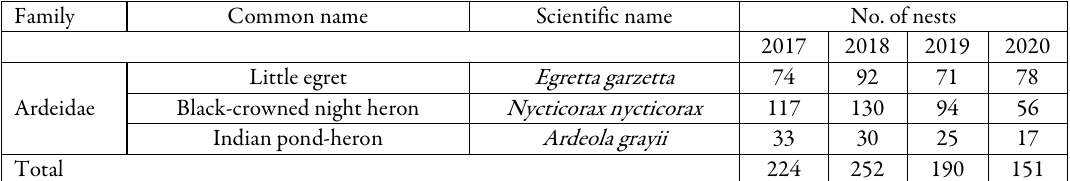
Table 2. Three species of heronry birds and their nest number observed in the study area Family Common name Scientific name No. of